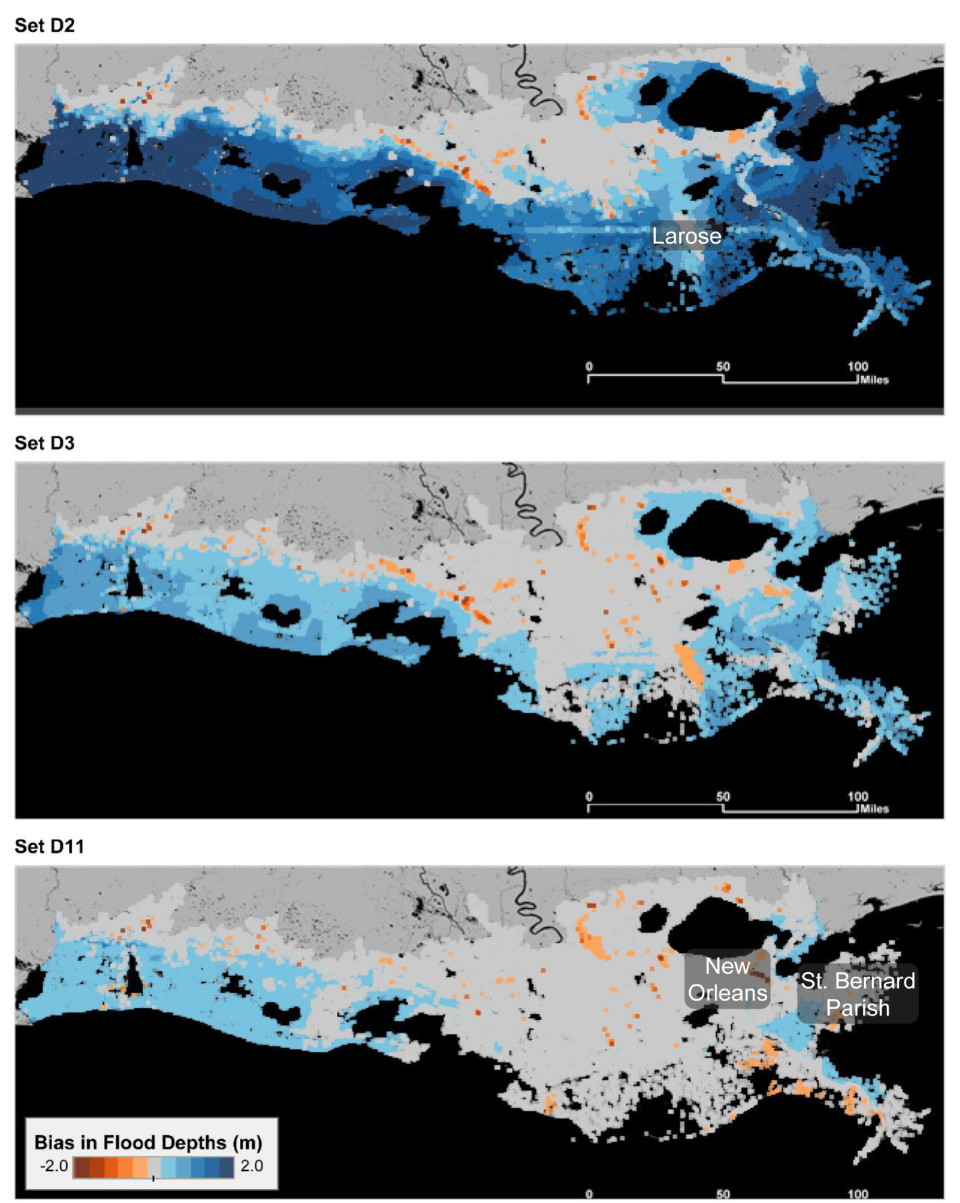
Figure 5. Maps of bias by grid point for detailed analysis sets D2, D3, and D11, 100 ‐ year flood depths.